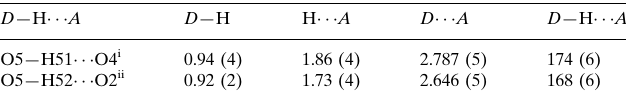
Hydrogen-bond geometry (A˚ , (cid:2)